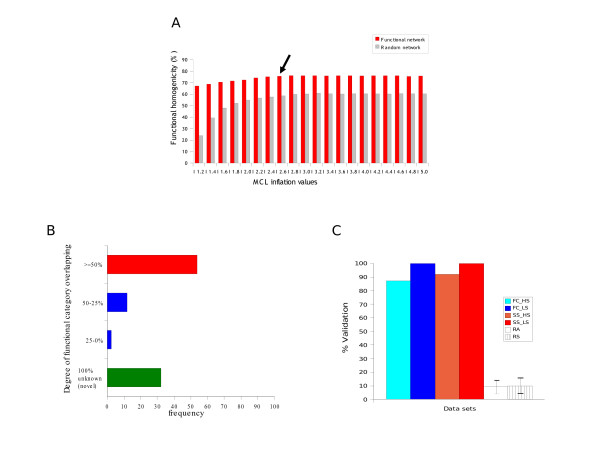
Functional module analyses. (A) Bars represent the average percentage of overlap in COGs [37] categories within module predictions at different MCL inflation values [35] for the S. meliloti (Sm) network and the average values of 100 random networks created with the same number of nodes and interactions as the Sm dataset. Black arrow stands for the Inflation value chosen for further analyses. Error bars are negligible and not shown for clarity. The percentage of overlap for each module was obtained by considering only the most abundant COGs category in the module. (B) Functional overlap of modules related to membership of COGs functional categories. (C) Accuracy of the functional network to predict correct COGs (FC) and symbiosis-stage annotations (SS) [see Additional file 2] in functional modules using a leave-one-out cross-validation procedure. Bars indicate the frequency of correct COGs/symbiosis-stage assignments. Two measures of stringency were employed: high (HS) and low stringency (LS). RA and RS refers to random networks of equal size to the S. meliloti network generated for COGs and symbiosis-stage correct annotation comparisons, respectively. Error bars indicate standard deviation for 100 replicate random controls.